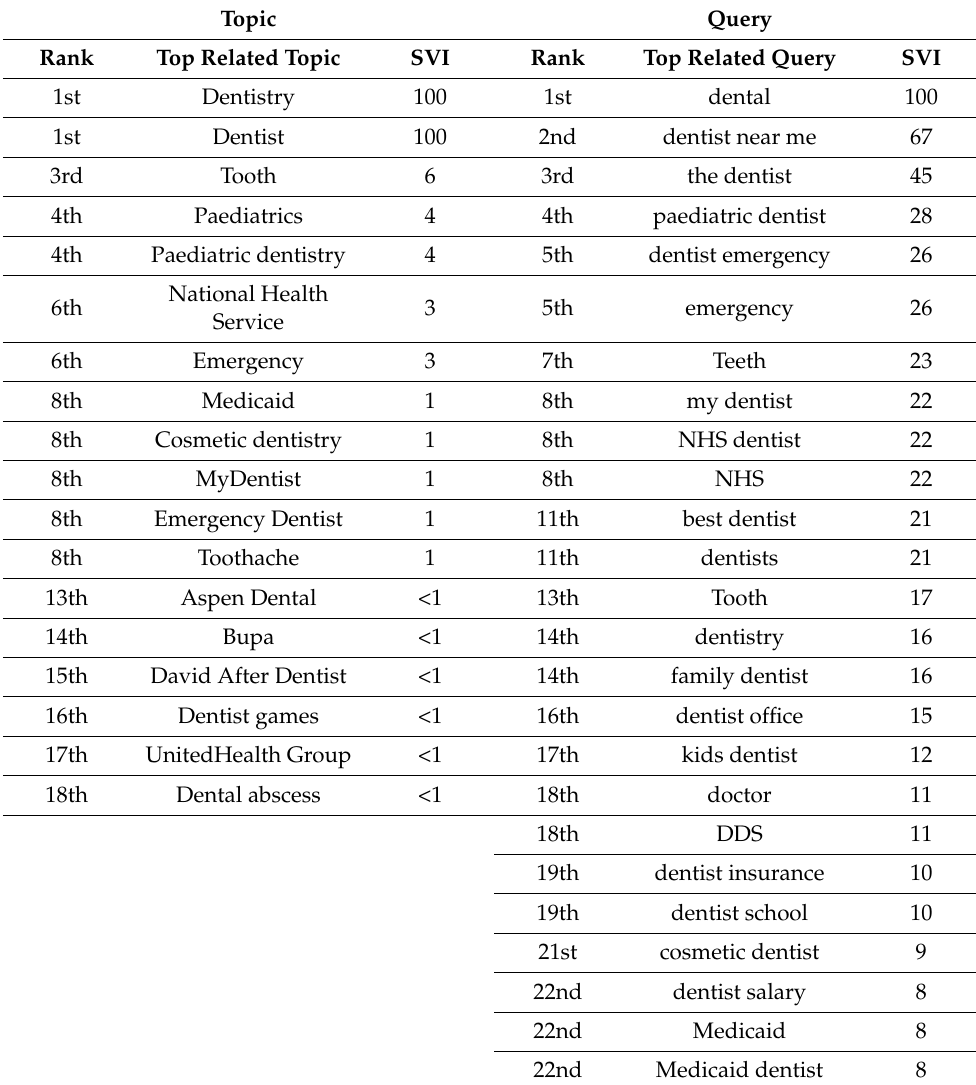
Table 2. The list of top related topics and queries on